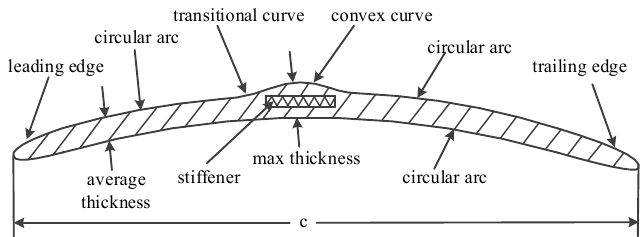
Figure 1. Schematic of thin circular-arc airfoil with convex structure. Table 1. Design parameters of the